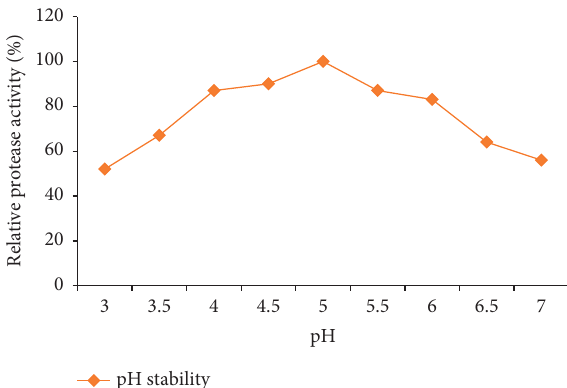
Figure 12: pH stability test for acetone-precipitated enzyme from the isolate